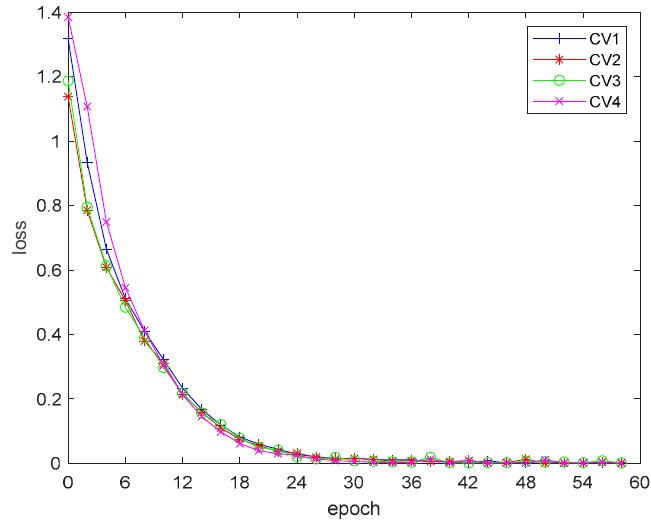
Figure 9. Training loss during cross-training.